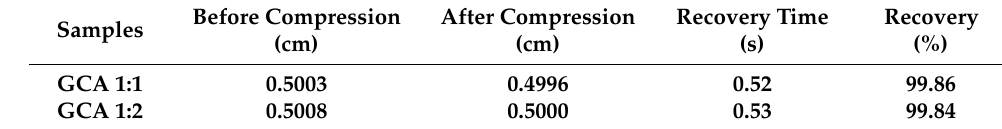
Table 1. Characteristics of the GCA recovery test.